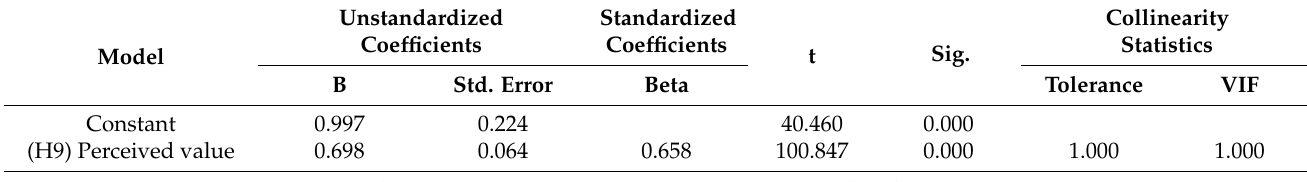
Table 7. Results of analysis of the effect of perceived value on recommendation intention.